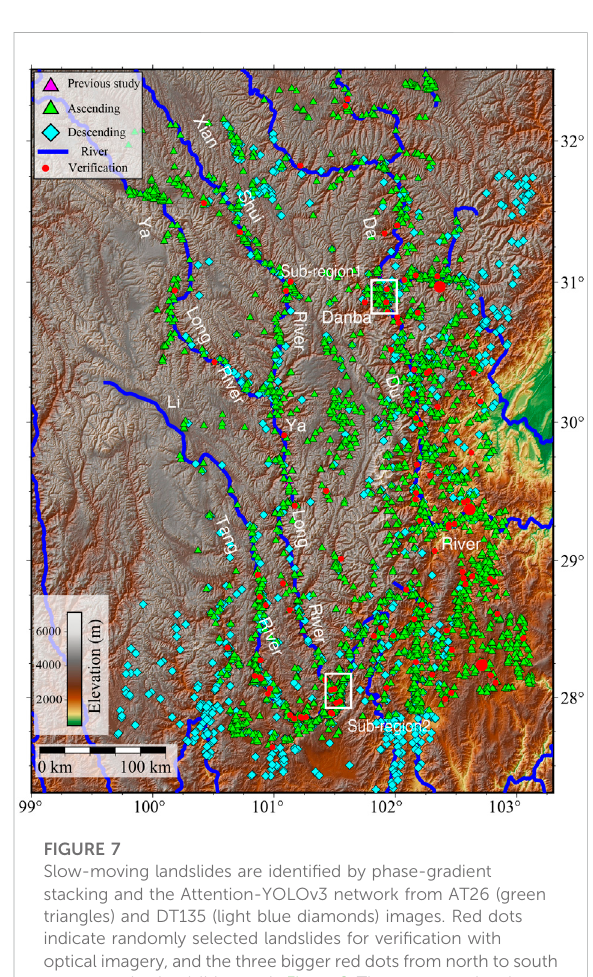
FIGURE 7 Slow-moving landslides are identi fi ed by phase-gradient stacking and the Attention-YOLOv3 network from AT26 (green triangles) and DT135 (light blue diamonds) images. Red dots indicate randomly selected landslides for veri fi cation with optical imagery, and the three bigger red dots from north to south correspondtolandslidesa-cinFigure8.Themagentatrianglesare the same as in Figure